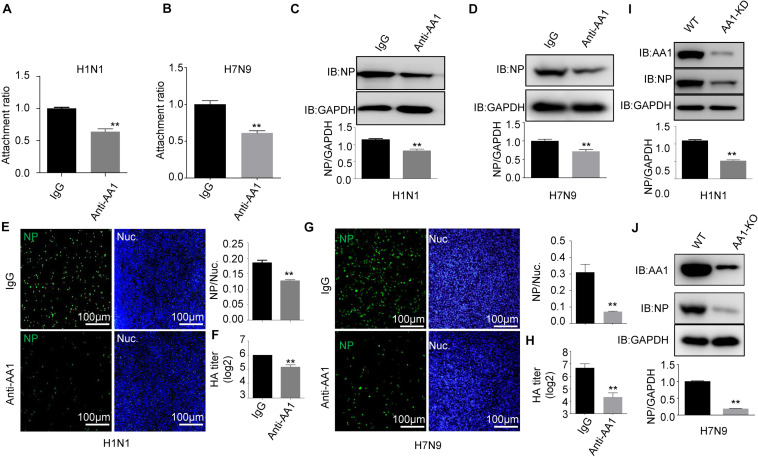
Blocking A549 cells with anti-HSP90AA1 antibody or knocking down of HSP90AA1 inhibits IAV infection. (A,B) A549 cells were incubated with DMEM in the presence of anti-HSP90AA1 antibodies (anti-AA1) or control IgG at 4°C for 1 h and then were inoculated with (A) H1N1 or (B) H7N9 for 2 h at 4°C. Attachment ratio of H1N1 and H7N9 viruses were quantified by measuring NP levels through qPCR. (C,D) A549 cells were incubated with DMEM in the presence of anti-HSP90AA1 antibodies (anti-AA1) or control IgG at 4°C for 1 h and then infected A549 cells with (C) H1N1 or (D) H7N9 for another 12 h at 37°C after attachment of the virus to A549 cells. Cells were lysed and subjected to immunoblotting analysis by using indicated antibodies. (E,G) After infection of the virus to A549 cells as described in panels (C,D), cells were then fixed. Confocal analysis was then performed. (F,H) After attachment of the virus to A549 cells as described in panels (C,D), cells were cultured in DMEM for another 48 h, cell culture supernatant was harvested, and a standard hemagglutination assay determined virus titers in supernatants. (I,J) Western blotting analysis of NP levels after virus infection for 12 h in wild type or HSP90AA1-knockdown (AA1-KD) cells. Error bars: mean ± SD of three independent tests. Two-way ANOVA; *P < 0.05; **P < 0.01 compared with control.